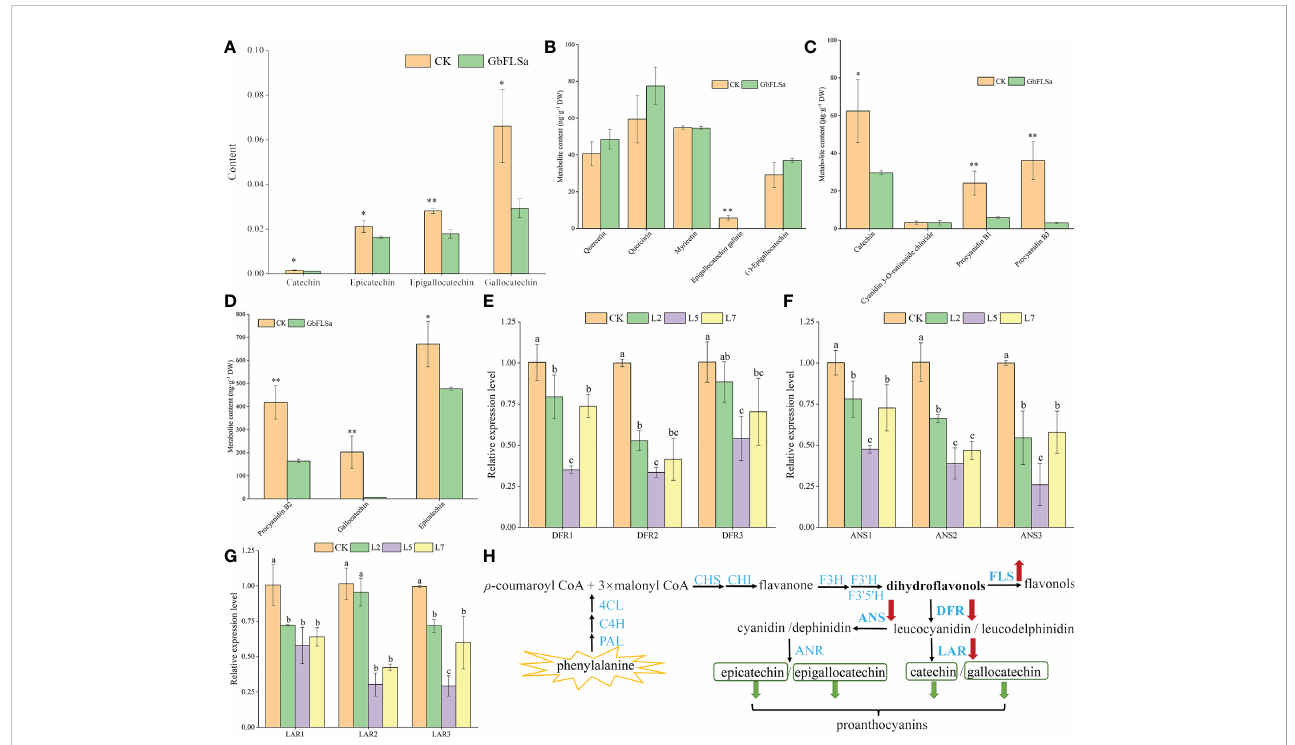
FIGURE 5 Flavonoid-related metabolite contents, enzyme gene expression levels and their biosynthesis pathways between the CK and transgenic plants. (A) . Comparison of four differential metabolite contents via GC – MS analysis. Columns with different lowercase letters signi fi cantly (p<0.05) differed based on Duncan ’ s multiple range test. (B – D) represent the metabolite content of fl avonoids between transgenic and CK plants by LC – MS analysis. (E – G) represent the relative expression levels of three enzyme-related genes by RT – qPCR analysis between the nontransgenic Populus and transgenic Populus groups. (H) Flavonoid biosynthesis pathway. * represents P < 0.05; ** represents P <